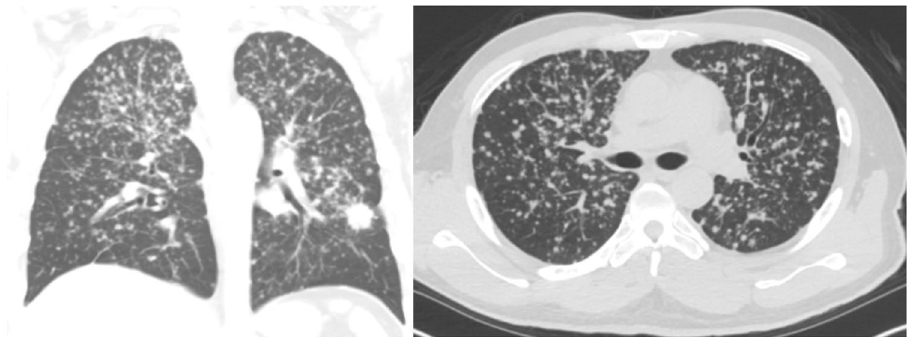
Figure 1. Examples of NSCLC patient with miliary lung